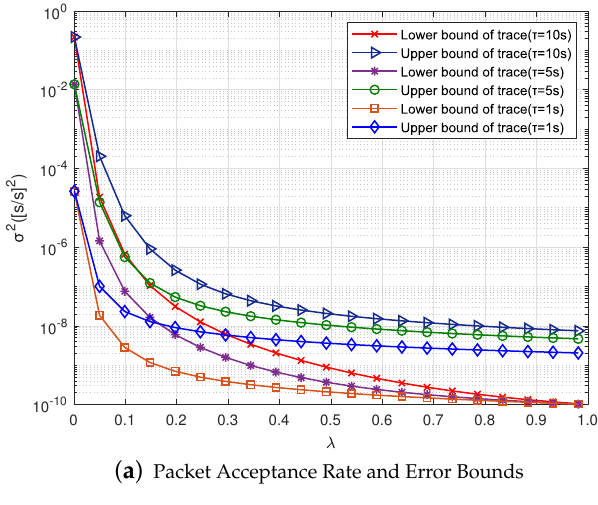
( a ) Packet Acceptance Rate and Error Bounds Figure 11. Cont